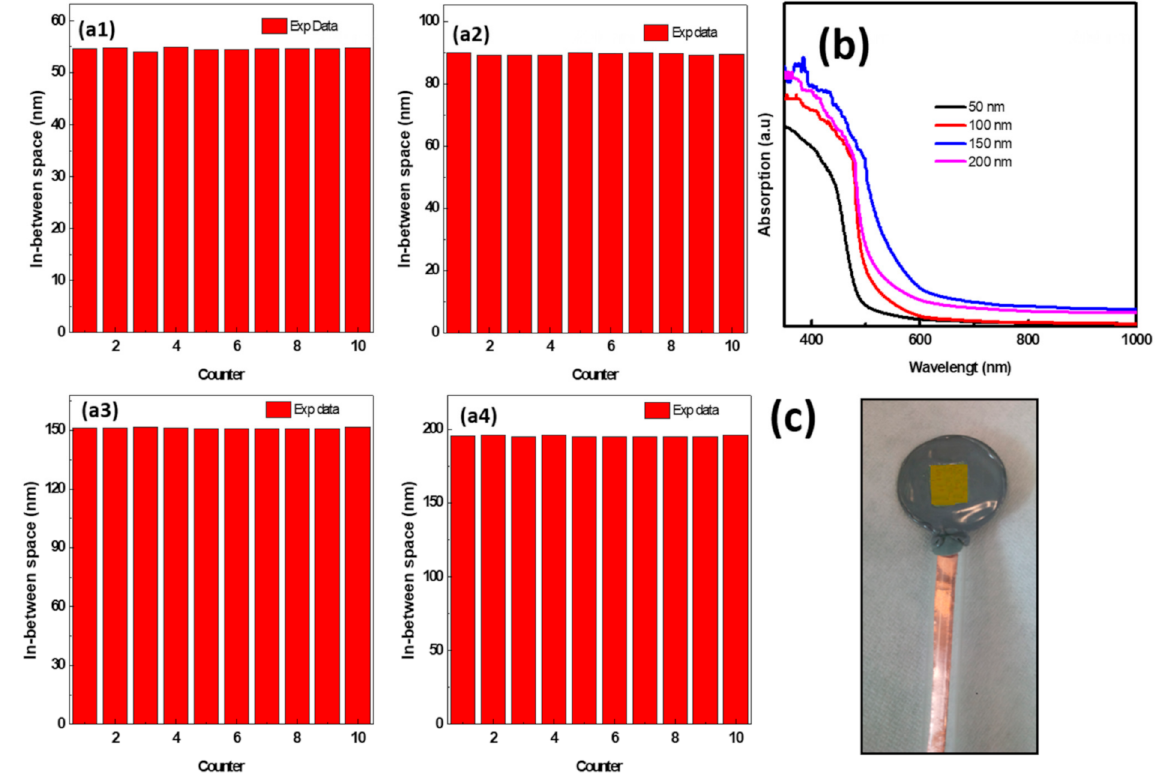
Figure 4. The average measurement of the samples of the photoanode of the CuWO 4 nanorod arrays with distinct gaps between the nanorod arrays of ( a1 ) 50 nm, ( a2 ) 100 nm, ( a3 ) 150 nm, and ( a4 ) 200 nm; ( b ) the absorption measurement within the UV–Vis light range of each photoanode samples; and ( c ) image of the photoanode of the CuWO 4 nanorod arrays covered with epoxy used for the electrical properties